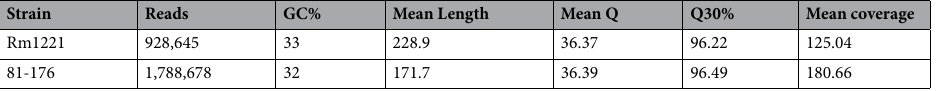
Table 1. Reference Strain MiSeq Sequencing Data. Sequencing metrics were determined using QUAST for MiSeq data.